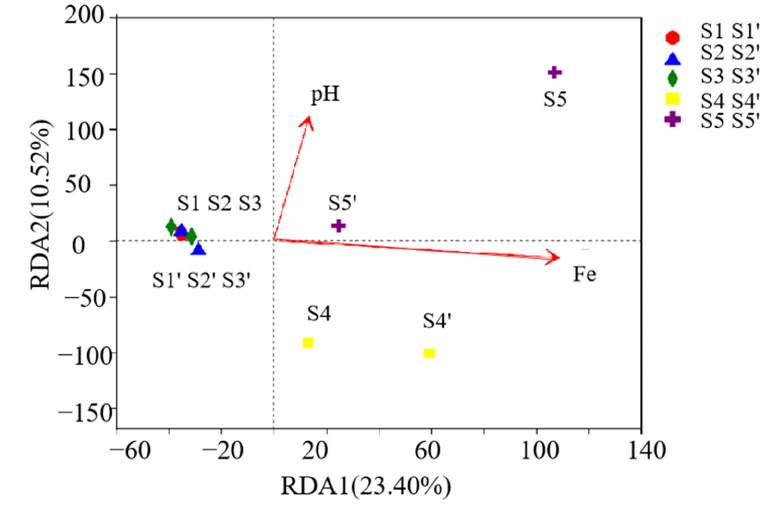
Figure 5. Correlation analysis of acid-producing microorganisms (RDA: Redundancy analysis).